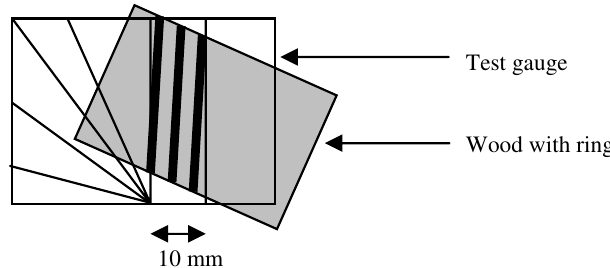
Fig. 3. Checking the number of rings for 10 mm according to EN 117 [4] standard.